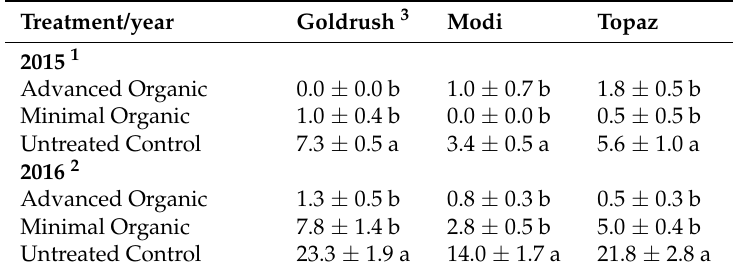
Table 7. Development of blossom blight in selected varieties under different organic management programs,